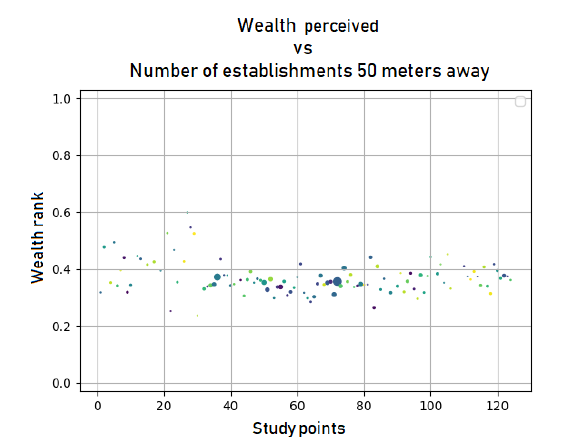
Figure 13. Relation between Wealth VS Number of establishments nearby. It can be seen that the Wealth perception has a inverse relation with the Number of establishments.